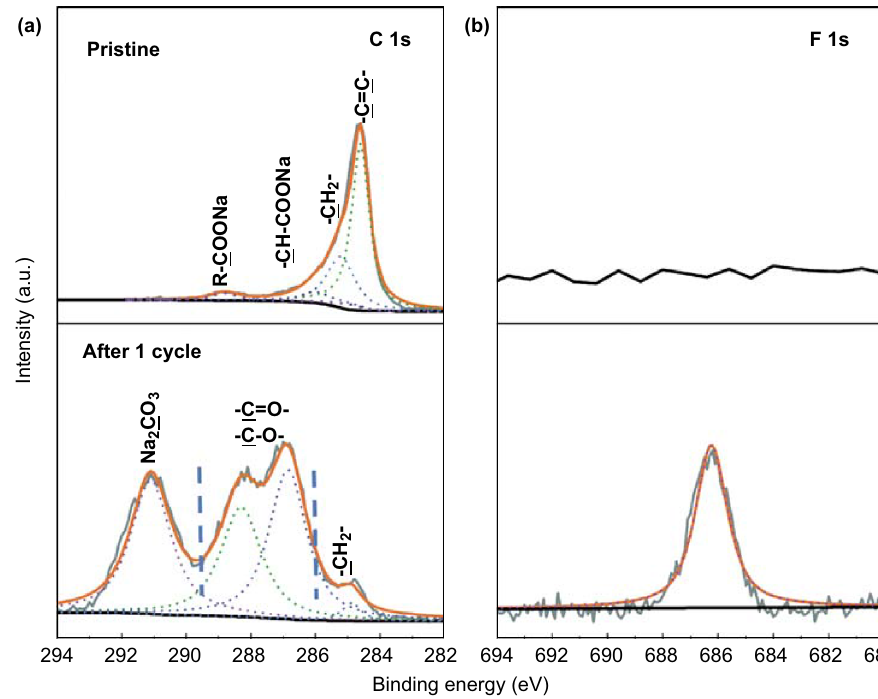
Fig. 4 High-resolution XPS spectra a C 1 s and b F 1 s of the Bi 2 Se 3 /C electrode before and after one